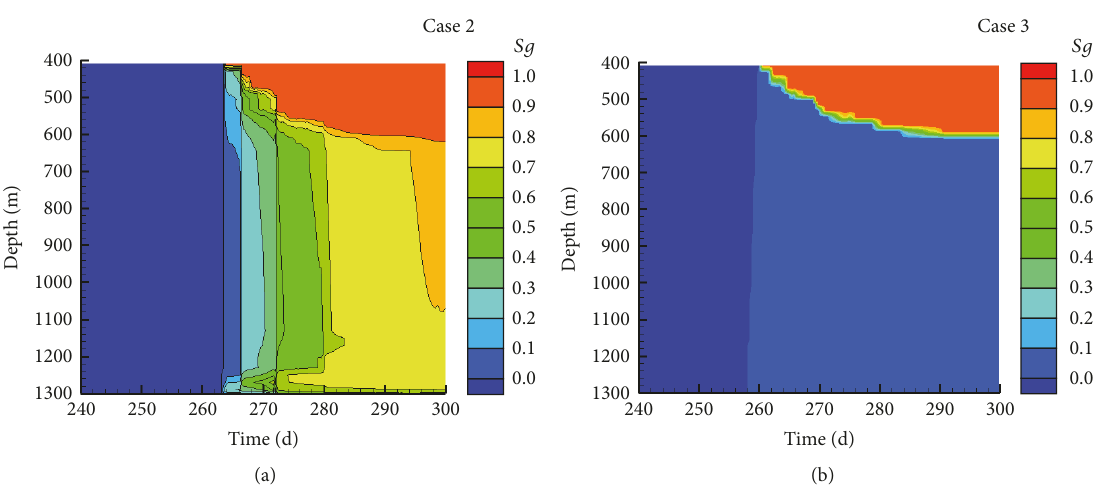
Figure 10: Gas saturation changes in the fracture in Case 2 and Case 3 associated with CO 2